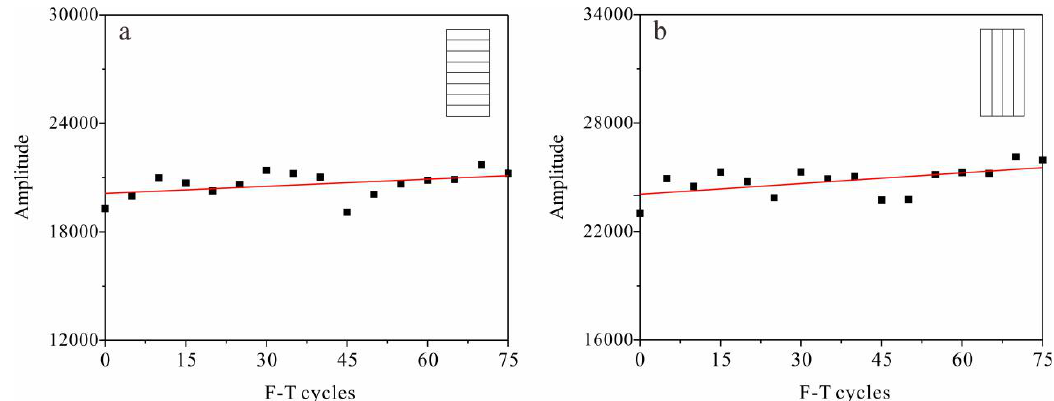
Figure 8. Variation in total T 2 spectral area with F-T cycles in samples with ( a ) perpendicular bedding (S per ) and ( b ) parallel bedding (S par ).